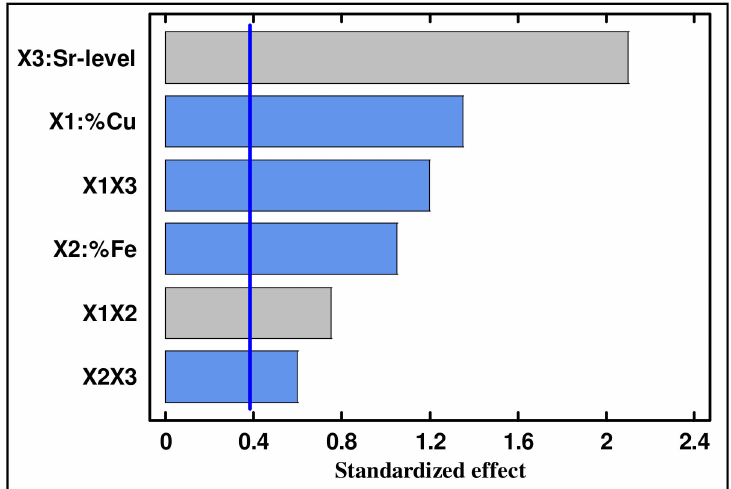
Figure 5. Pareto charts of the standardized effects for the elongation